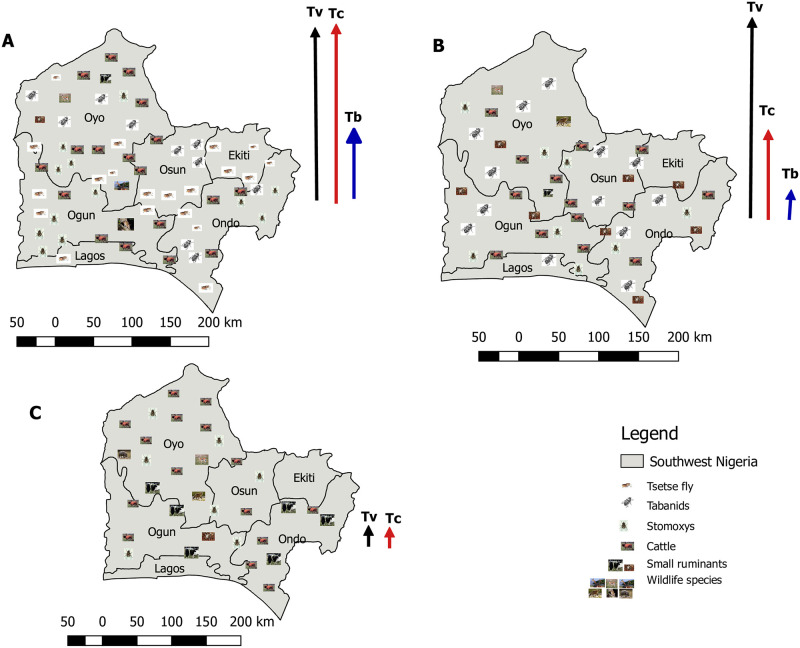
Simulated situation of AAT in southwest Nigeria.A. Areas with abundant tsetse flies, biting flies, cattle, small ruminants and wildlife, with a high prevalence of Trypanosoma spp. B. Absence of tsetse flies was depicted, but biting flies, cattle, small ruminants and wildlife present, the T. vivax is high. C. Absence of all the vectors when ITC and ITT is used along with trypanocides. There are still wildlife reservoirs and herds of cattle and small ruminants. Abbreiations: Tv- Trypanosoma vivax, Tc- Trypanosoma congolense, Tb- Trypanosoma brucei brucei